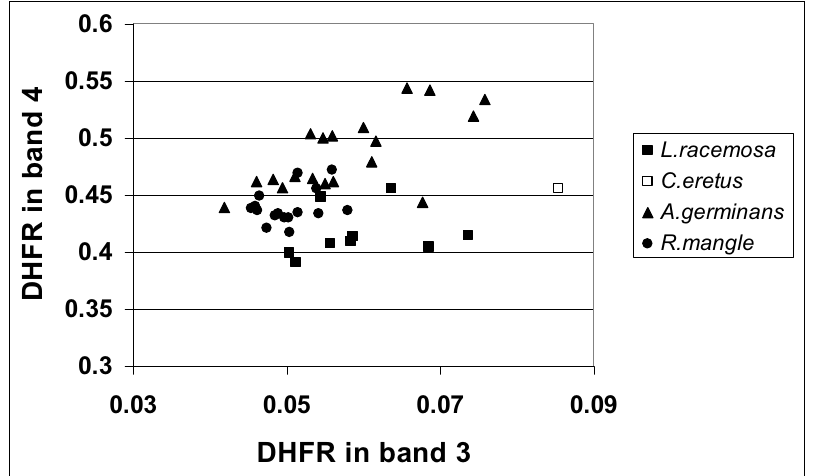
Fig. 4 – DHFR band 4 × DHFR band 3 scatter plot.